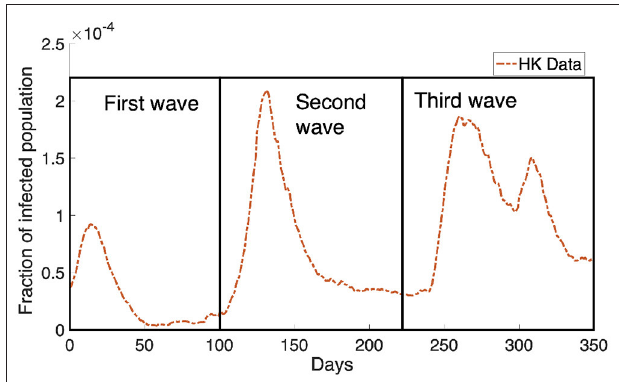
FIGURE 1 | The Hong Kong infected population obtained from Department of Health, Government of HKSAR (20) is shown in the orange dotted curve. We can see the infected population rebound multiple times in the data, causing the dynamics of the infected population to look like waves. There are three waves where we have boxed them and marked them as the first wave, the second wave and the third wave as shown in the